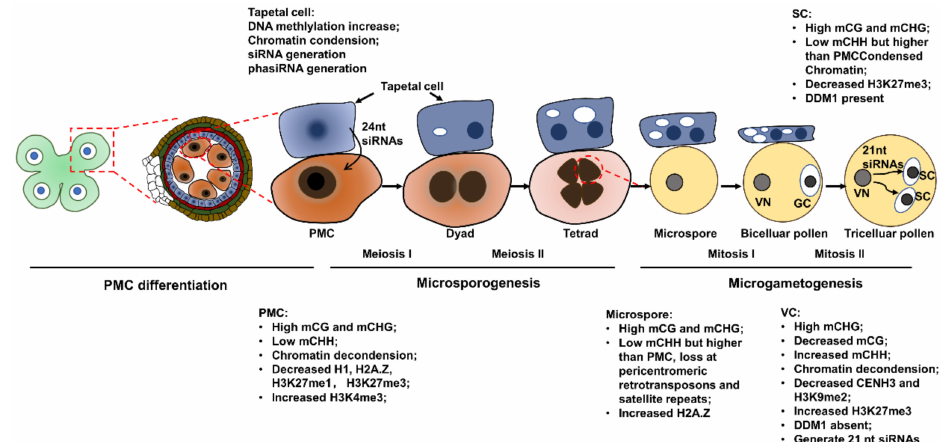
Figure 1. Epigenetic dynamics during plant male reproduction. Epigenetic profiles of each type of cells are described in the text. GC, generative cell; mCG, CG methylation; mCHG, CHG methylation; mCHH, CHH methylation; PMC, pollen mother cell; SC, sperm cell; VN, vegetative cell